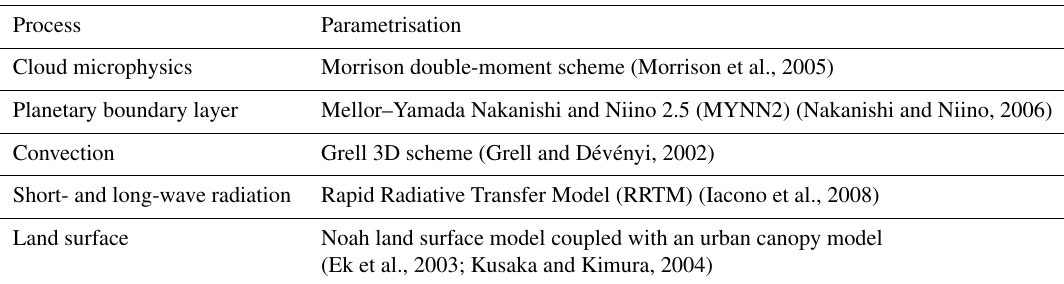
Table B1. Chosen parametrisations for meteorological processes in